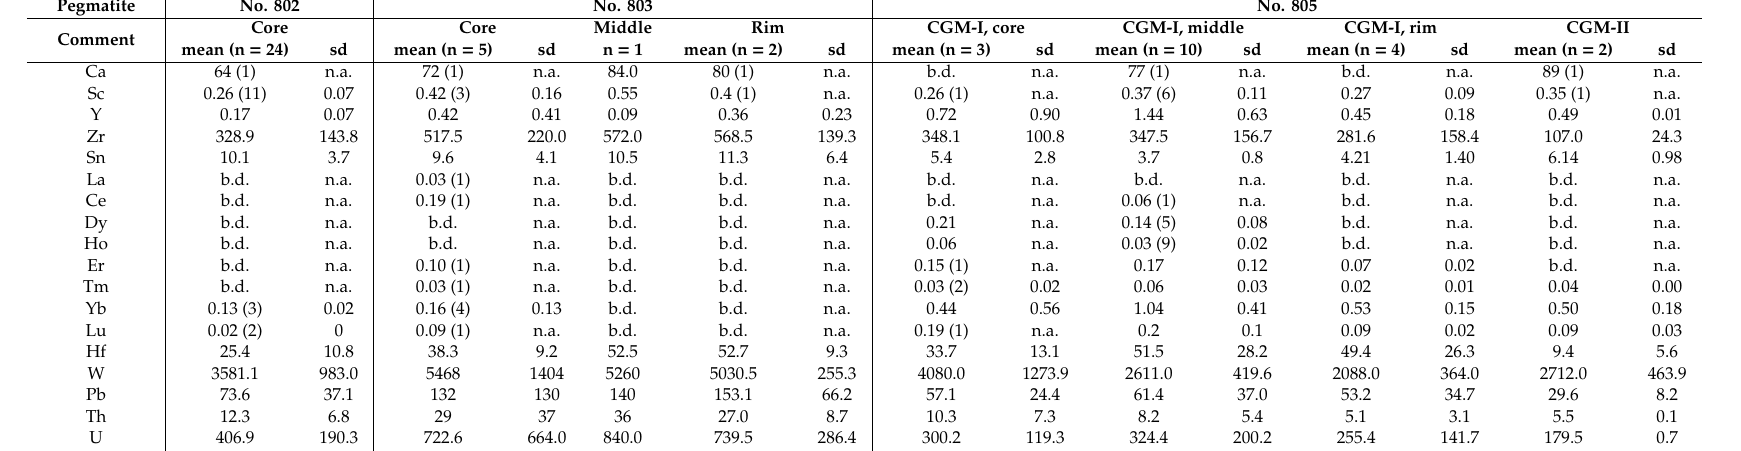
Table 4. Summary of trace element concentrations (in ppm) of CGMs obtained by